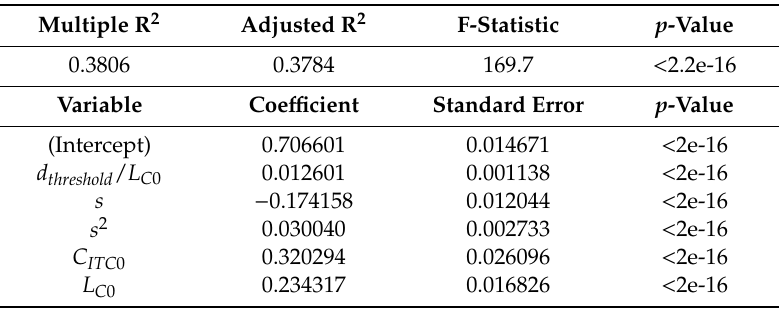
Table 3. Regression analysis of hexahedron cell ratio.